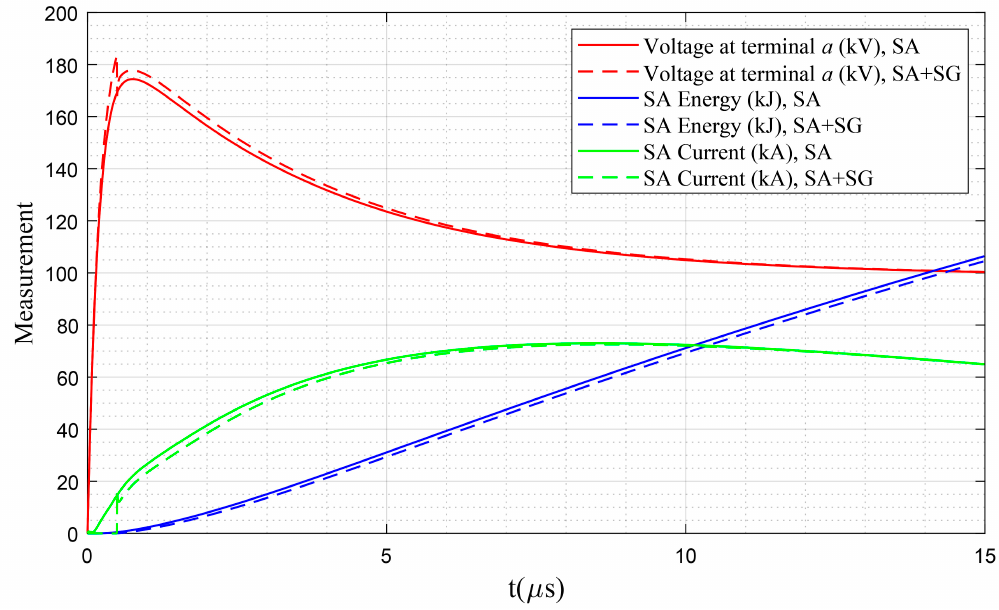
Figure 32. Comparison of the energy absorbed by di ff erent surge arresters against the 200 kV lightning impulse.